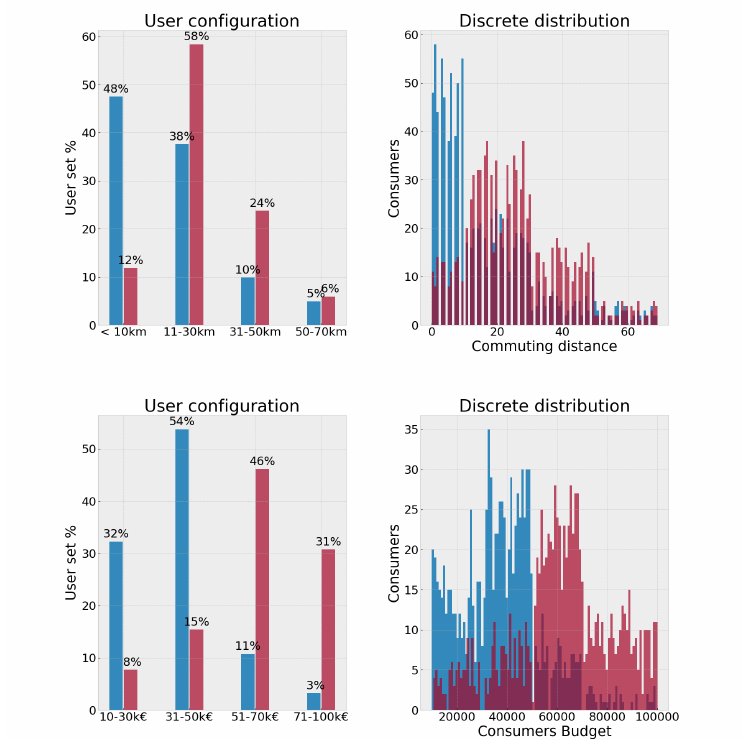
Figure 4. Two different option settings for commuting distances and budget distributions (red and blue bars, respectively, in the two lines). The left panels show different examples of user inputs. The right panels show the generated discrete distribution for 1000